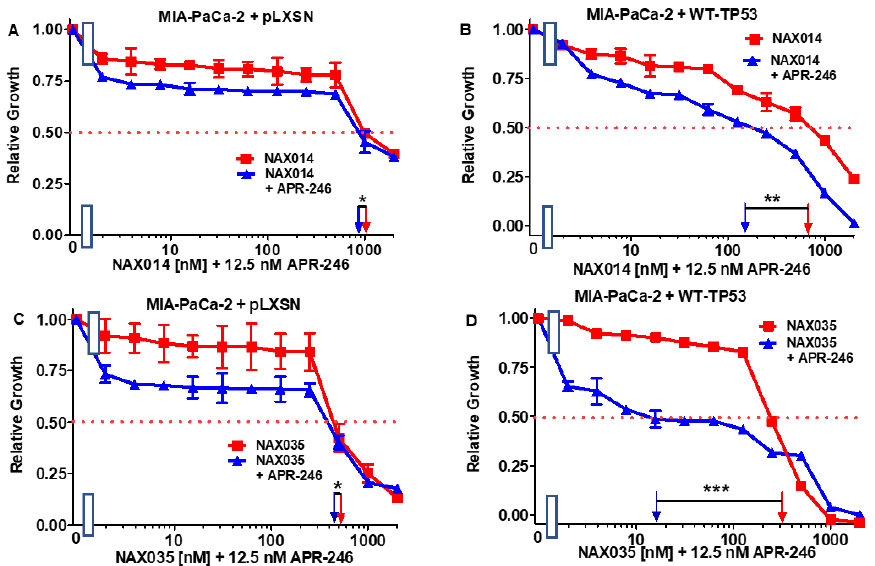
Figure 4. APR-246 is more effective in enhancing the effects of NAX014 and NAX035 in MIA-PaCa-2 cell when WT-TP53 is present. Panel ( A ) MIA-PaCa-2 + pLXSN cells treated with different concentrations of NAX014 (red squares) or with different concentrations of NAX014 and a low dose of APR-246 (blue triangles). Panel ( B ) MIA-PaCa-2 + WT-TP53 cells treated with different concentrations of NAX014 (red squares) or with different concentrations of NAX014 and a low dose of APR-246 (blue triangles). Panel ( C ) MIA-PaCa-2 + pLXSN cells treated with different concentrations of NAX035 (red squares) or with different concentrations of NAX035 and a low dose of APR-246 (blue triangles). Panel ( D ) MIA-PaCa-2 + WT-TP53 cells treated with different concentrations of NAX035 (red squares) or with different concentrations of NAX035 and a low dose of APR-246 (blue triangles). The experiments were repeated 4 times, and similar results were observed. *** = p < 0.0001, ** = p < 0.005,* = p < 0.05, NS, not statistically significant. In the presence of APR-246, the sensitivity of MIA-PaCa-2 + pLXSN cells to NAX035 decreased only slightly (1.1-fold), but in MIA-PaCa-2 + WT-TP53 cells, the TP53 reactivator reduced the NAX035 IC 50 almost 19-fold (Figure 4C,D). Addition of the low dose of APR-246 had a mild effect on the sensitivity of both MIA- PaCa-2 + pLXSN MIA-PaCa-2 + WT-TP53 cells to NAX038 as the IC 50 decreased, respectively, 1.2- and 1.3-fold (Figure 5A,B).